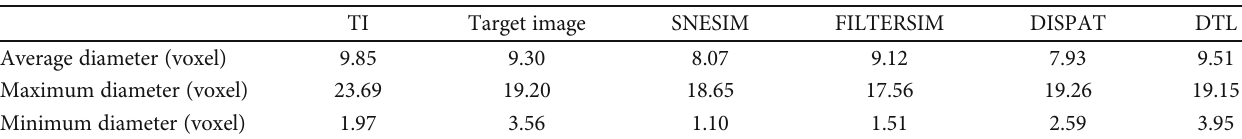
Table 7: The average pore diameters (sandstone) in the TI, the target image, and the reconstructed images of SNESIM, FILTERSIM, DISPAT, and DTL.